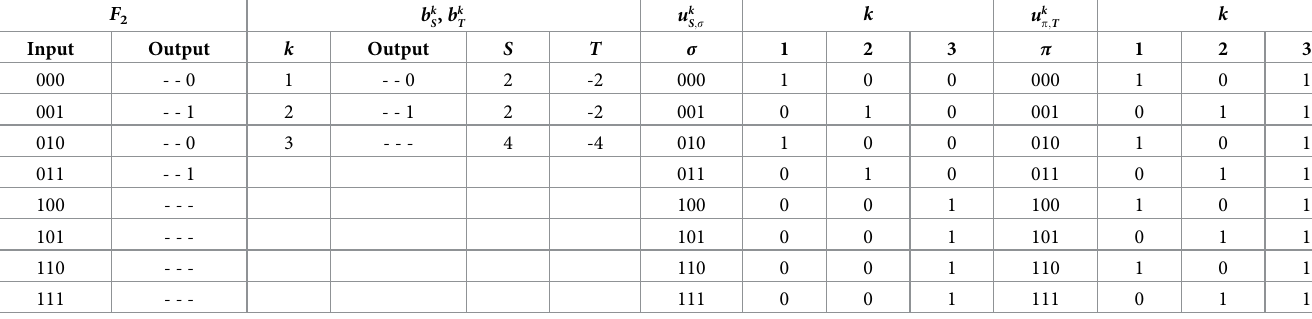
Table 5. Truth table and parameters of incompletely specified function F 2